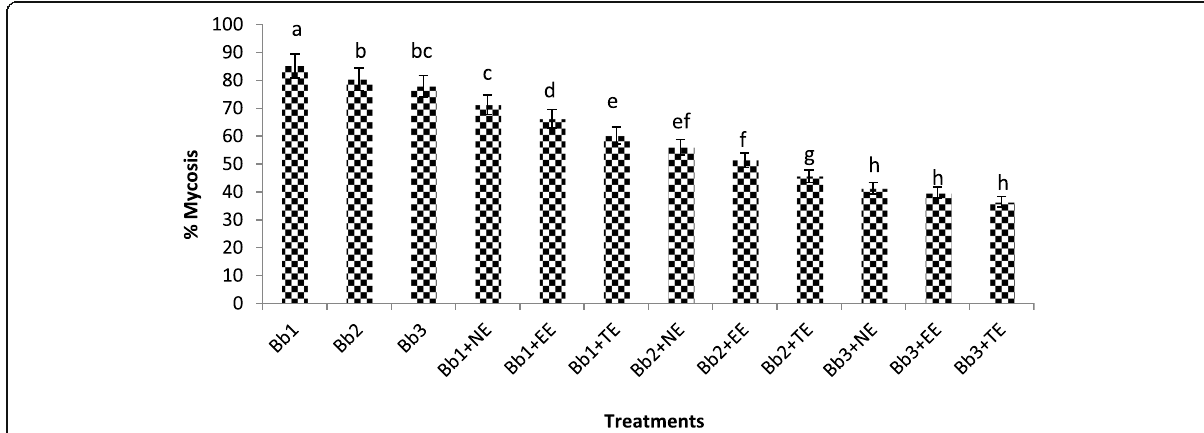
Fig. 1 Impact of the plant extracts and Beauveria bassiana (Bb) concentrations on (%) mycosis in cadavers of 3rd instars larvae of Tribolium castaneum . Bars with the same letters are not significantly different at 5% significance level. Vertical bars reflect standard error (SE). Where the